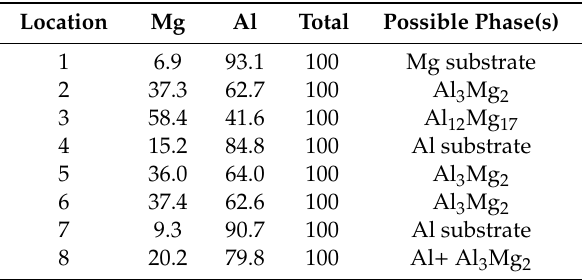
Table 3. Chemical compositions (Weight Percent) measured by energy-dispersive spectroscopy (EDS) at Locations shown in Figure 6.